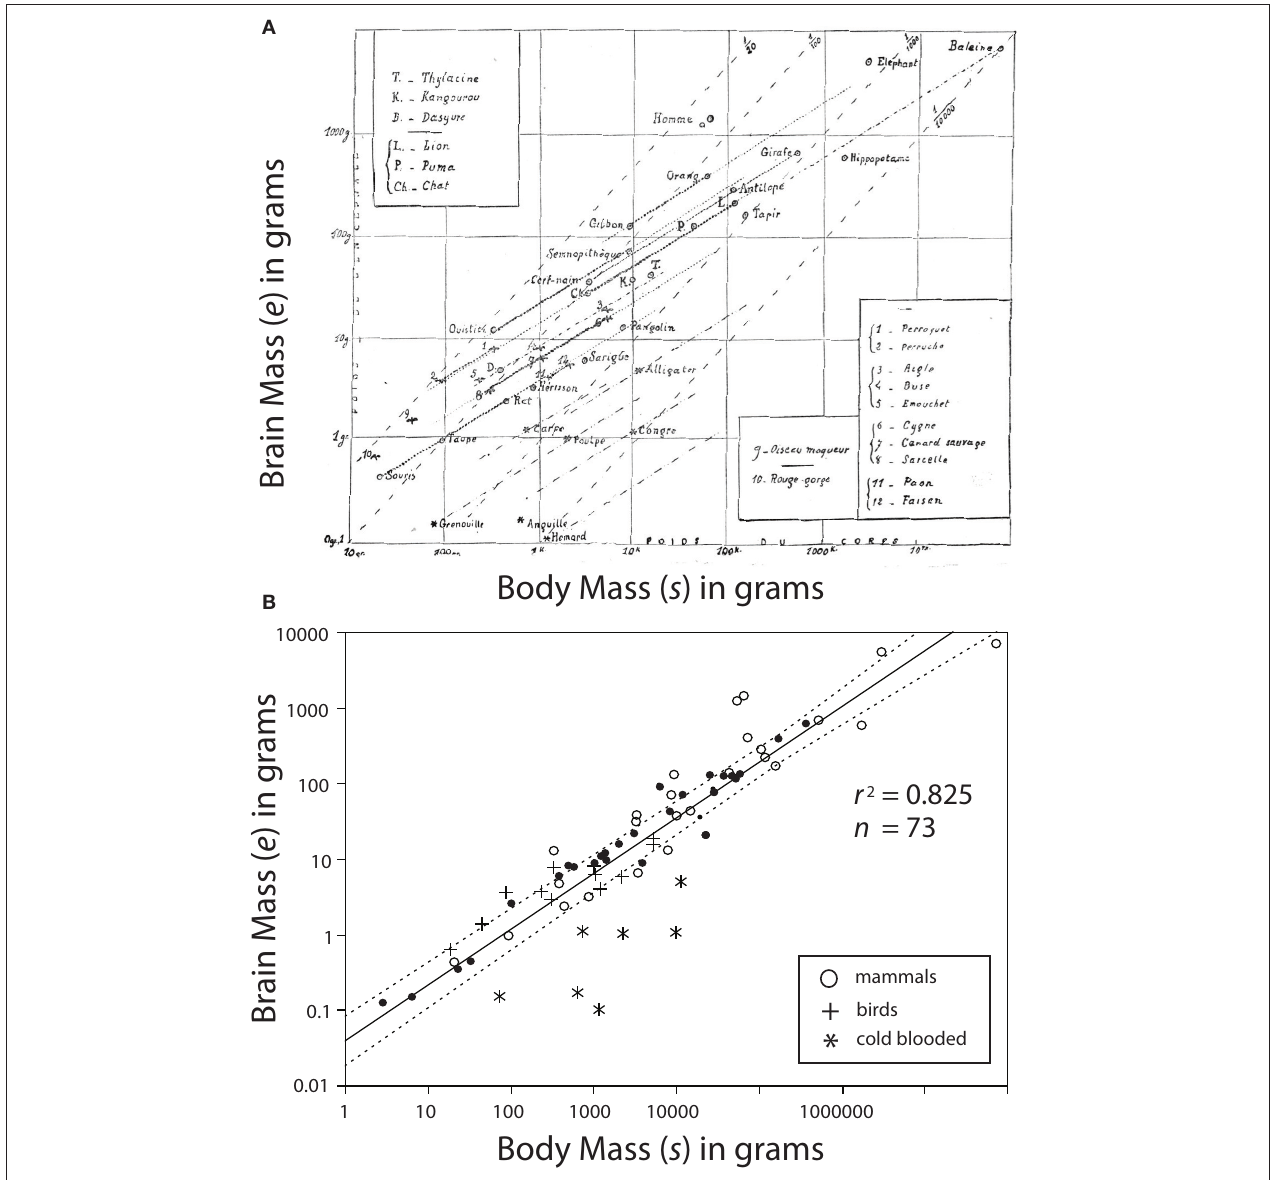
FIGURE 2 | Bivariate plot of brain mass e vs. body mass s . (A) A photo-copy of the first known log-log plot showing common slopes among allometric data published by Louis Lapicque (1866–1952) in 1907. Dark dashed lines represent regression curves for individual species; gray dashed lines represent boundaries of interspecific trends. (B) Lapicque’s data replotted to include data omitted from his original diagram. Missing data indicated by black circles. Reduced major axis regression curve and 95% CIs are